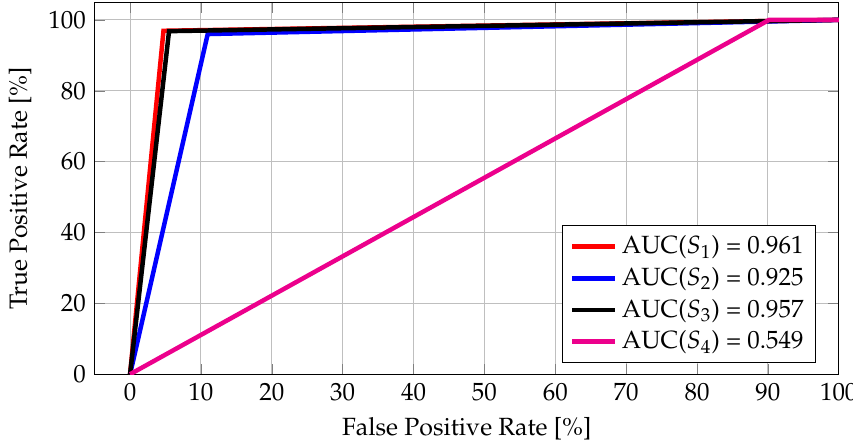
Figure 18. Receiver operating characteristics for all